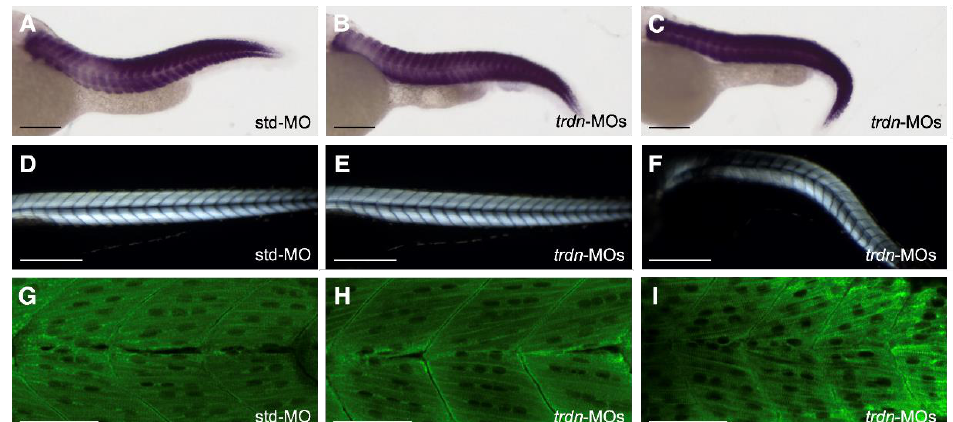
Figure 3. Skeletal muscle morphology evaluation. ( A – C ) Representative images of WISH analysis using a ckma probe in std-MO ( A ), class 1 wild-type-like ( B ) and class 3 affected ( C ) trdn -MO-injected embryos at 48 hpf. ( D – F ) Representative birefringence images of std-MO ( D ), class 1 wild-type-like ( E ) and class 3 affected ( F ) trdn -MO-injected embryos at 3 dpf. ( G – I ) Representative MF20 immunofluorescence images of std-MO ( G ), class 1 wild-type-like ( H ) and class 3 affected ( I ) trdn -MO-injected embryos. ( A – F ) Scale bars indicate 100 µm. ( G – I ) Scale bars indicate 50 μm.